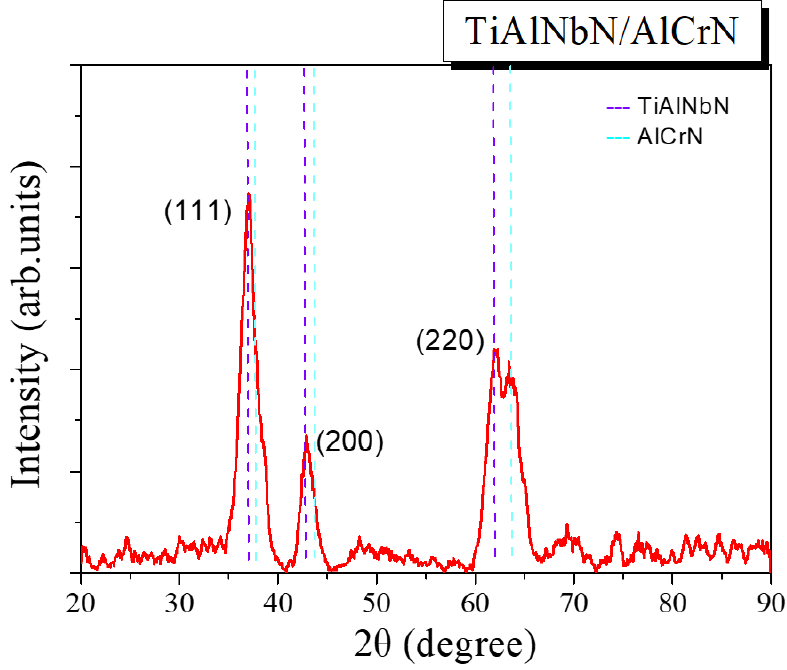
Figure 3. Glancing angle X-ray diffraction pattern of the deposited TiAlNbN/AlCrN coating.